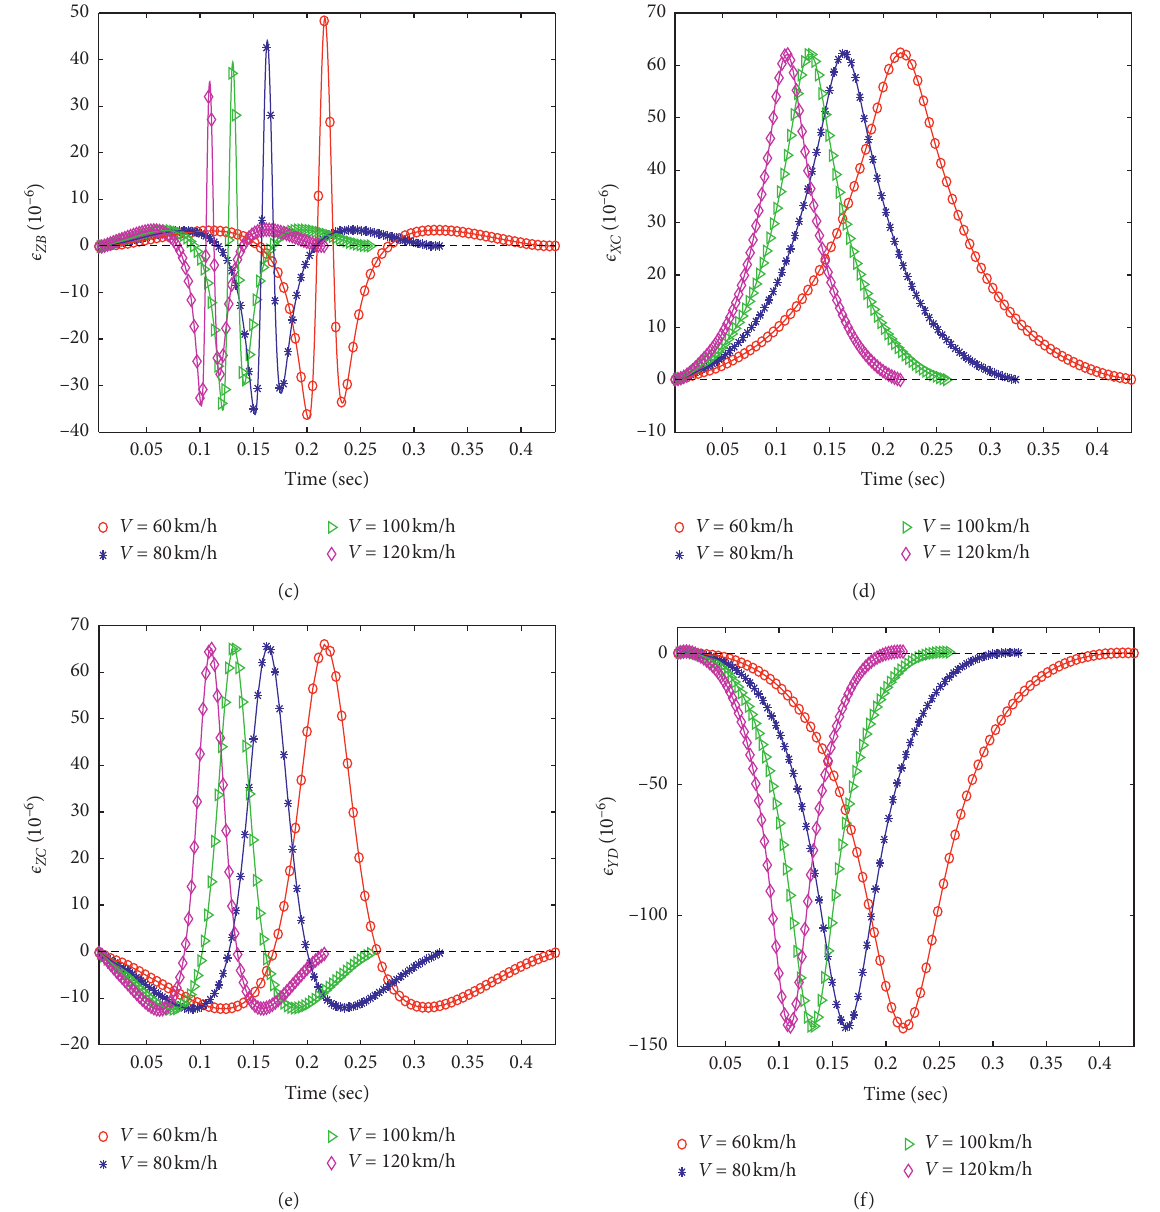
Figure 7: Response due to moving loads at the room temperature. (a) U YA at different vehicle speed. (b) ε XB at different vehicle speed. (c) ε ZB at different vehicle speed. (d) ε XC at different vehicle speed. (e) ε ZC at different vehicle speed. (f) ε YD at different vehicle